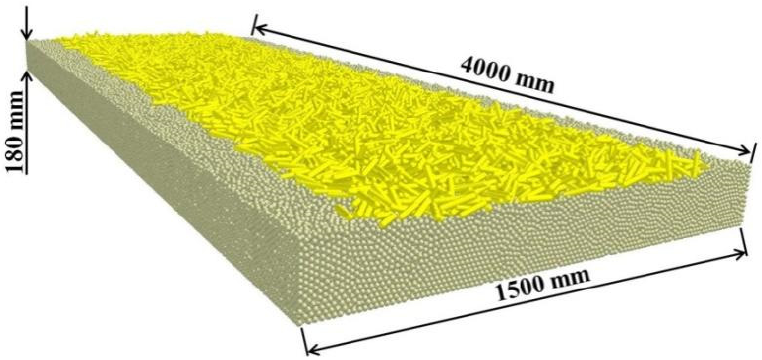
Figure 6. Virtual soil bin model.